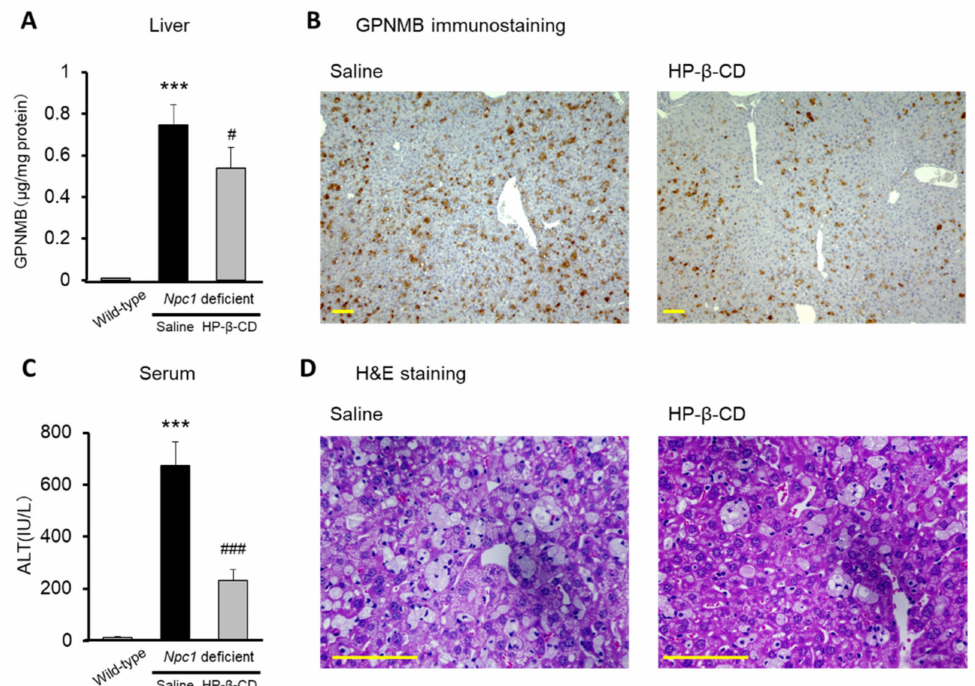
Figure 4. Attenuating effects of intracerebroventricular 2-hydroxypropyl- β -cyclodextrin (HP- β -CD) treatment on liver manifestations in Npc1 − / − mice. Glycoprotein nonmetastatic melanoma protein B (GPNMB) levels in liver homogenate ( A ), GPNMB immunohistochemistry in liver ( B ), serum alanine aminotransferase (ALT) levels ( C ), and hematoxylin-and-eosin (H&E)-stained hepatic histology ( D ) are shown. Scale bar: 100 µ m for GPNMB and H&E staining. Each bar represents the mean ± S.E.M. ( n = 8–11). *** p < 0.001 compared with the wild-type group. # p < 0.05, ### p < 0.001 compared with the saline